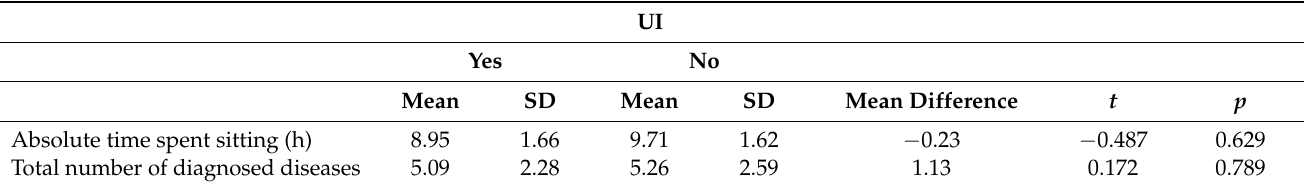
Table A2. Non-significant results ( p value over 0.200) between urinary incontinence (UI) and para- metric variables with the independent samples t -test among 68 residents living in five nursing homes (NHs) from Osona, Spain (2020).